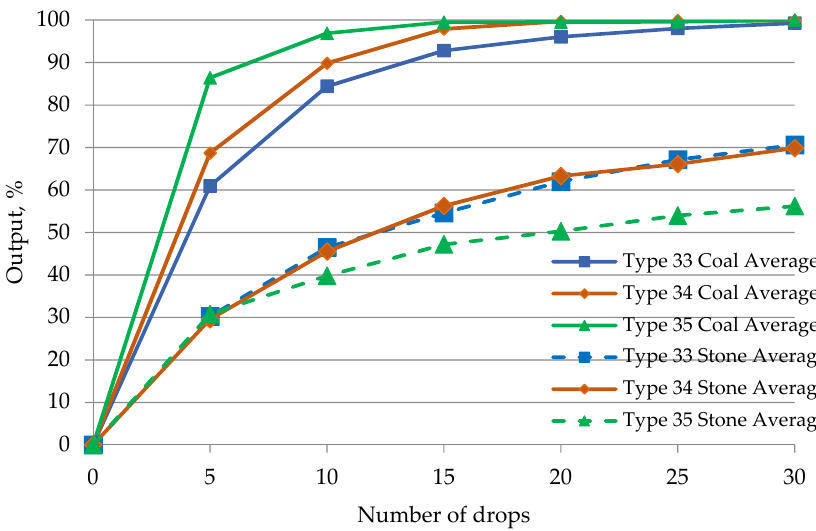
Figure 6. Comparative results of the 80-0 mm class output depending on the number of drops (average output) [43].